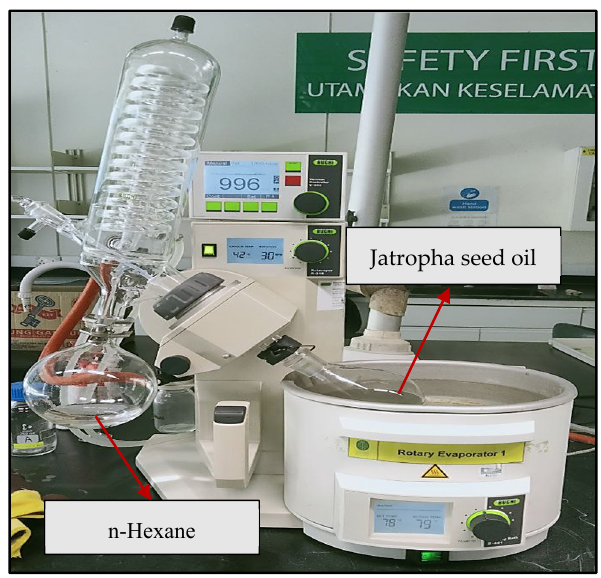
Figure 4. Rotary evaporator.